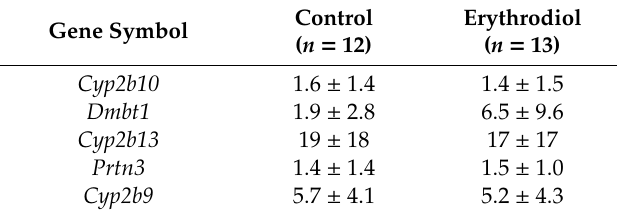
Table 4. Hepatic changes in selected gene expressions of female. Apoe -deficient mice receiving 10 mg / kg erythrodiol.